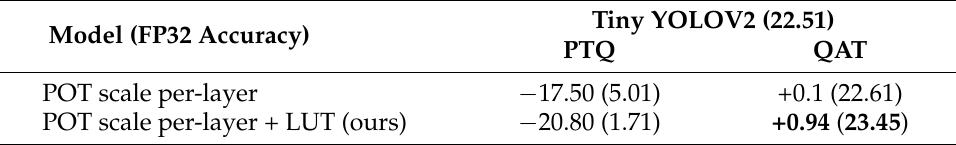
Table 4. Detection results on MS COCO in mean average precision (IoU 0.5) with 4 bit weights and 8 bit activations.